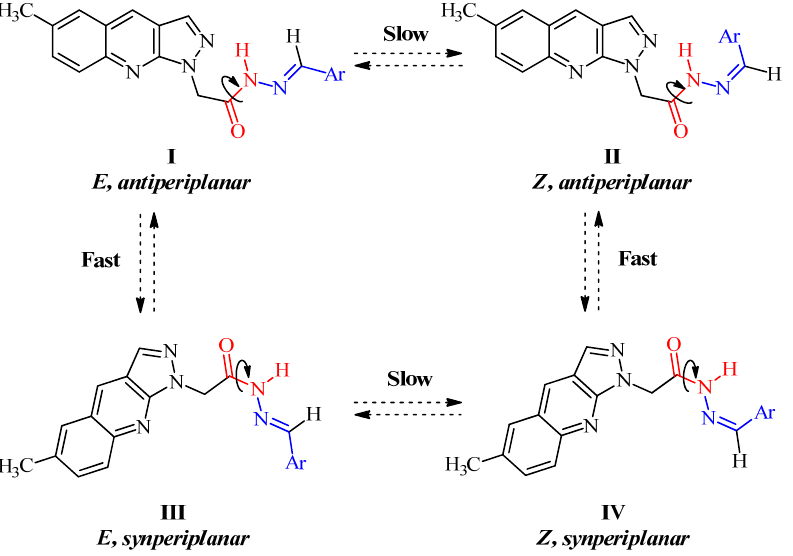
Figure 3. Rotational isomers arising due to C-N Bond C(O)-NH rotation.